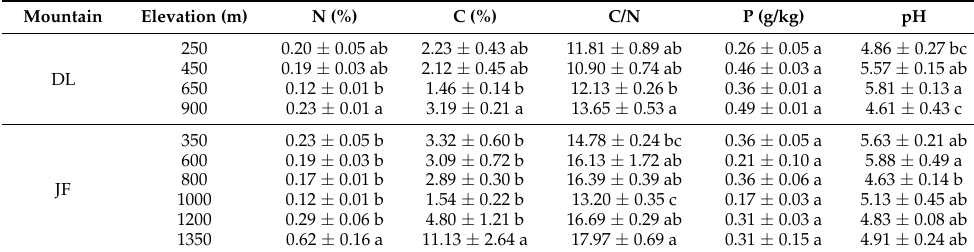
Table 2. The concentrations of soil nutrients at different